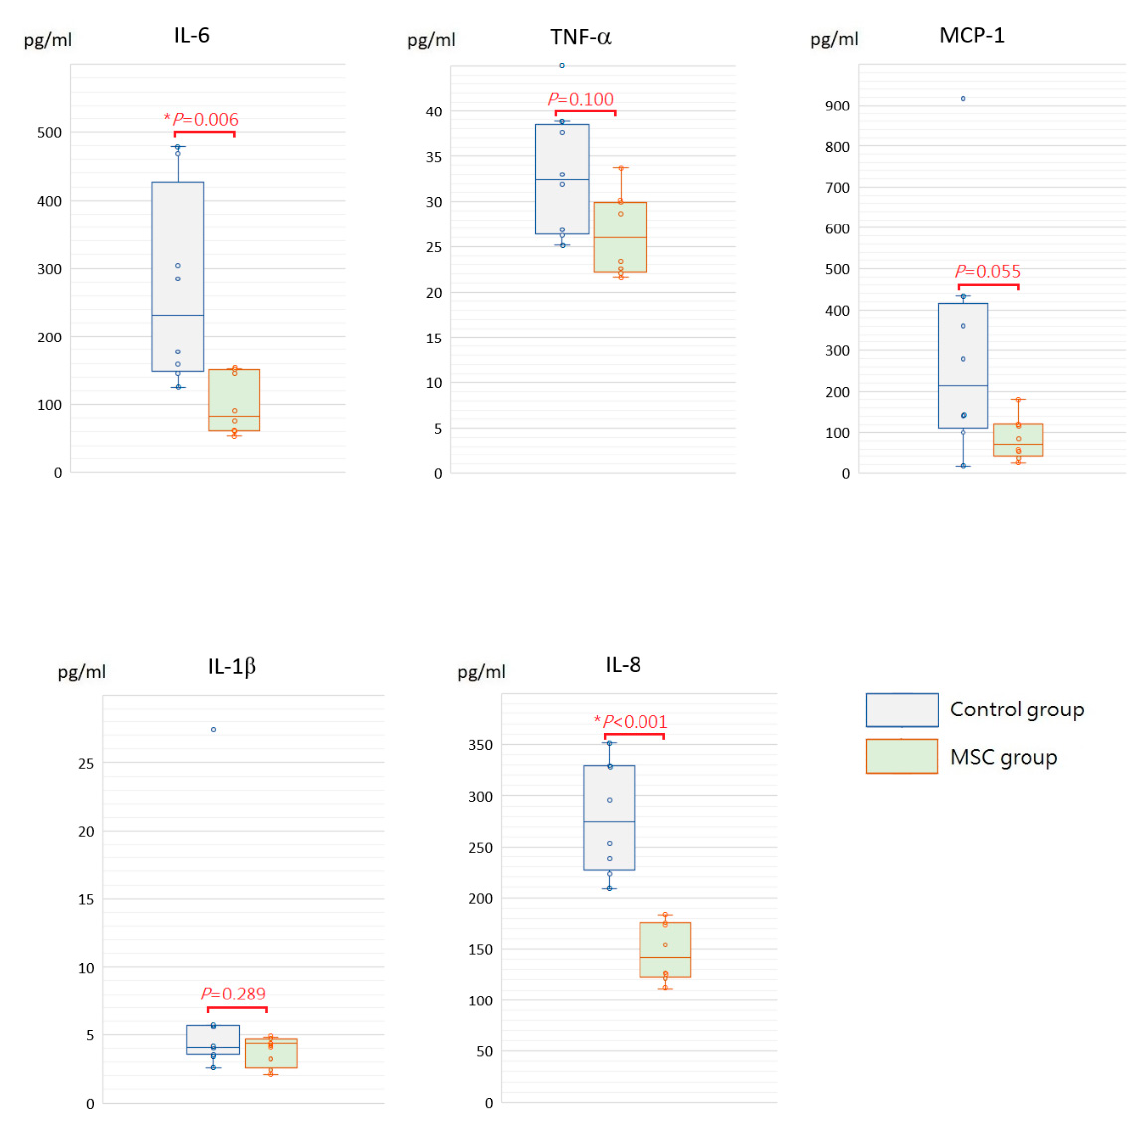
Figure 6. Boxplots of inflammatory cytokine levels in the BALF at 48 h after LPS-induced ALI. Compared to the control group, concentrations of IL-6 and IL-8 in the BALF were significantly decreased in the MSC group. Although not reaching statistical significance, levels of TNF- α , MCP-1, and IL-1 β trended lower in the MSC group. Each circle represents the concentration of each animal. n = 8